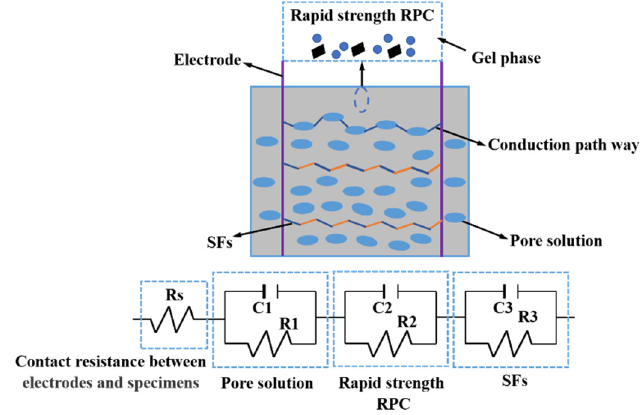
Figure 7. The equivalent circuit diagram.